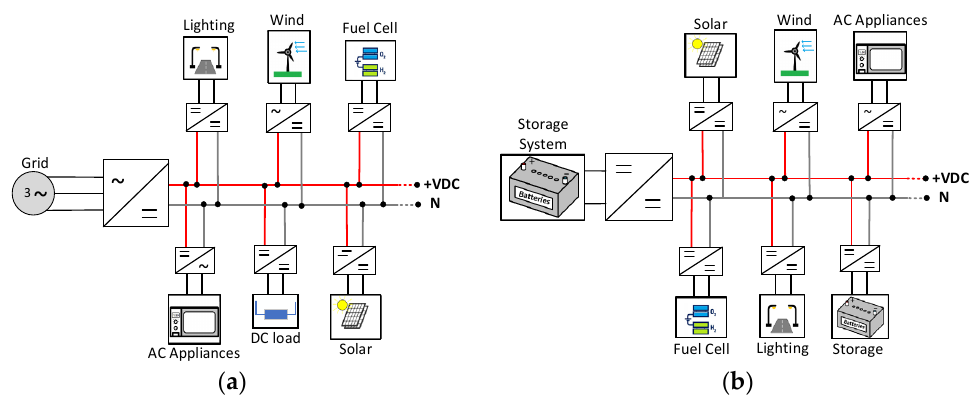
Figure 6. A schematic of typical example of the unipolar configuration: ( a ) connected to the grid and ( b ) operating in island